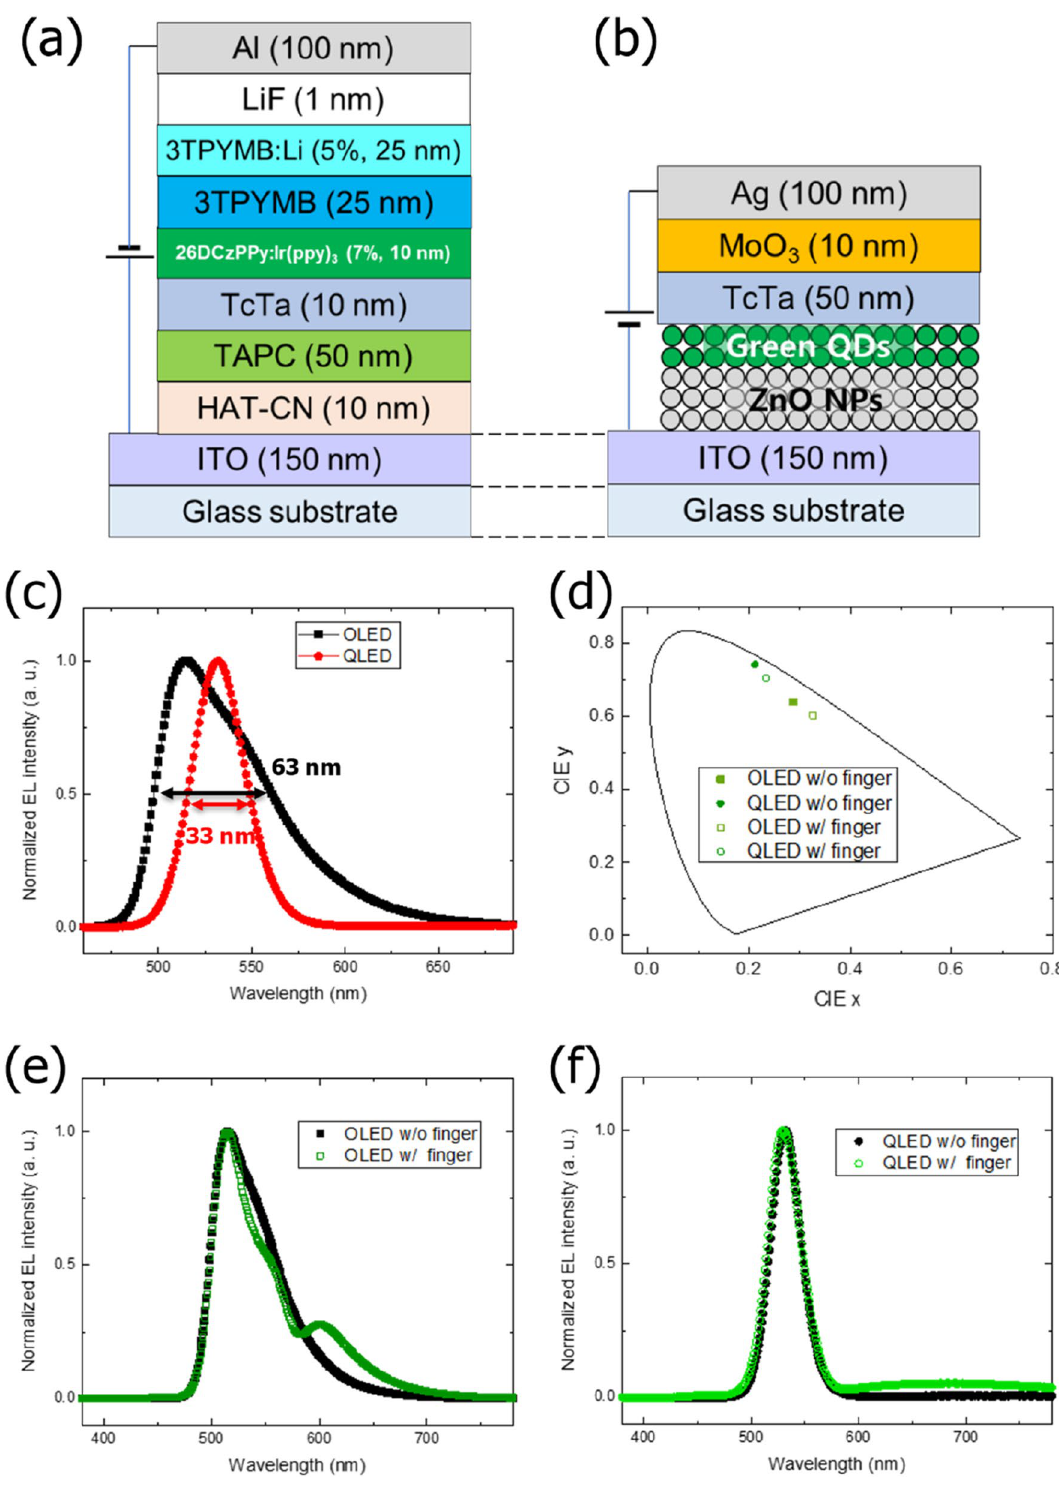
Figure 4. Device structures of ( a ) OLEDs and ( b ) QLEDs. ( c ) Normalized EL spectra of green OLED and QLED. ( d ) CIE 1931 color coordinates for EL spectra of OLED and QLED without (w/o) and with (w/) human finger. Normalized EL spectra of ( e ) OLED and ( f ) QLED w/o and w/ human